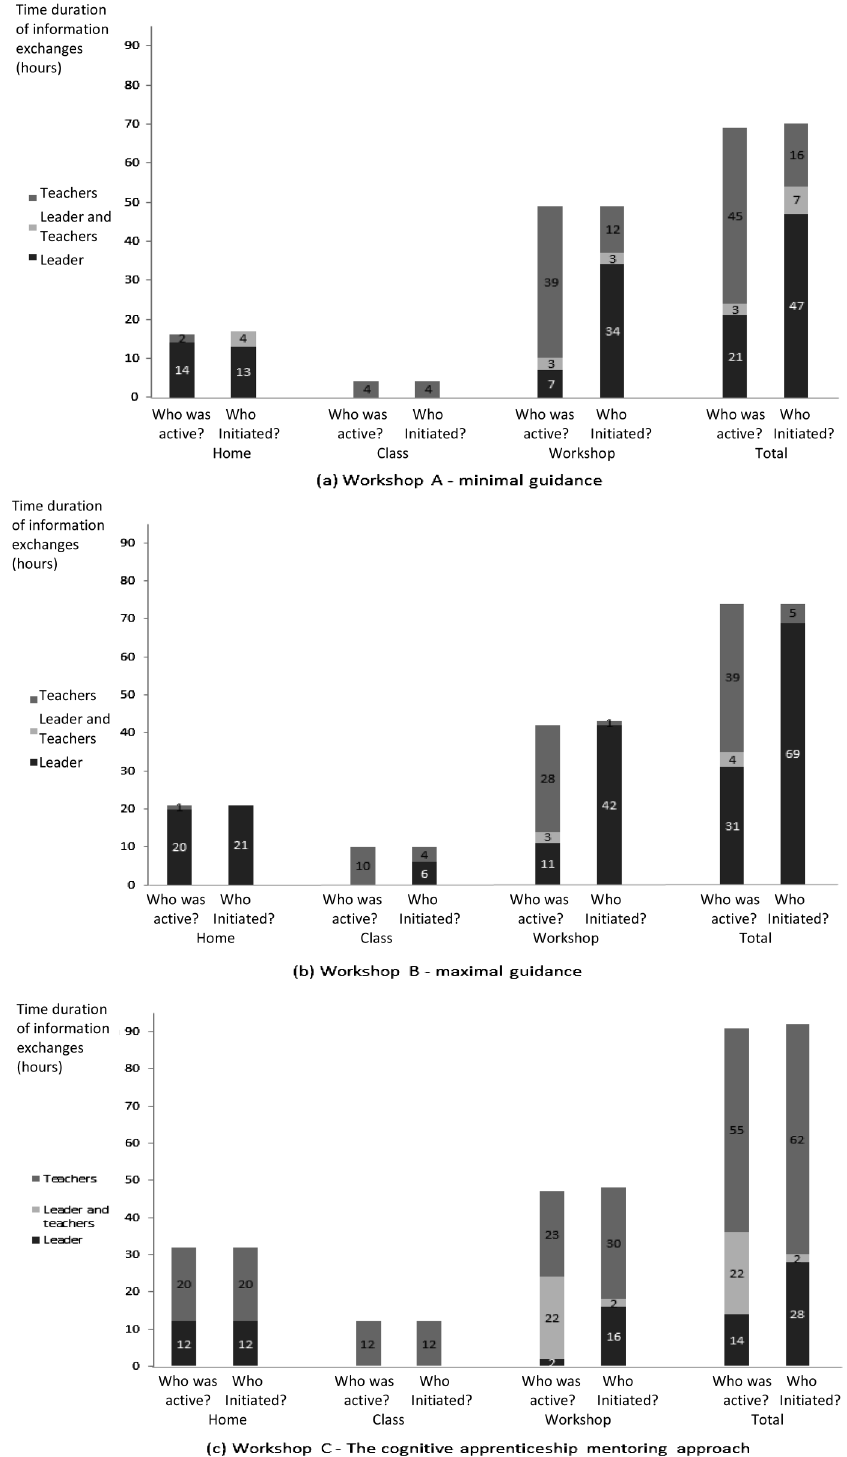
FIG. 2. Frequency and time duration of information exchange by active party and